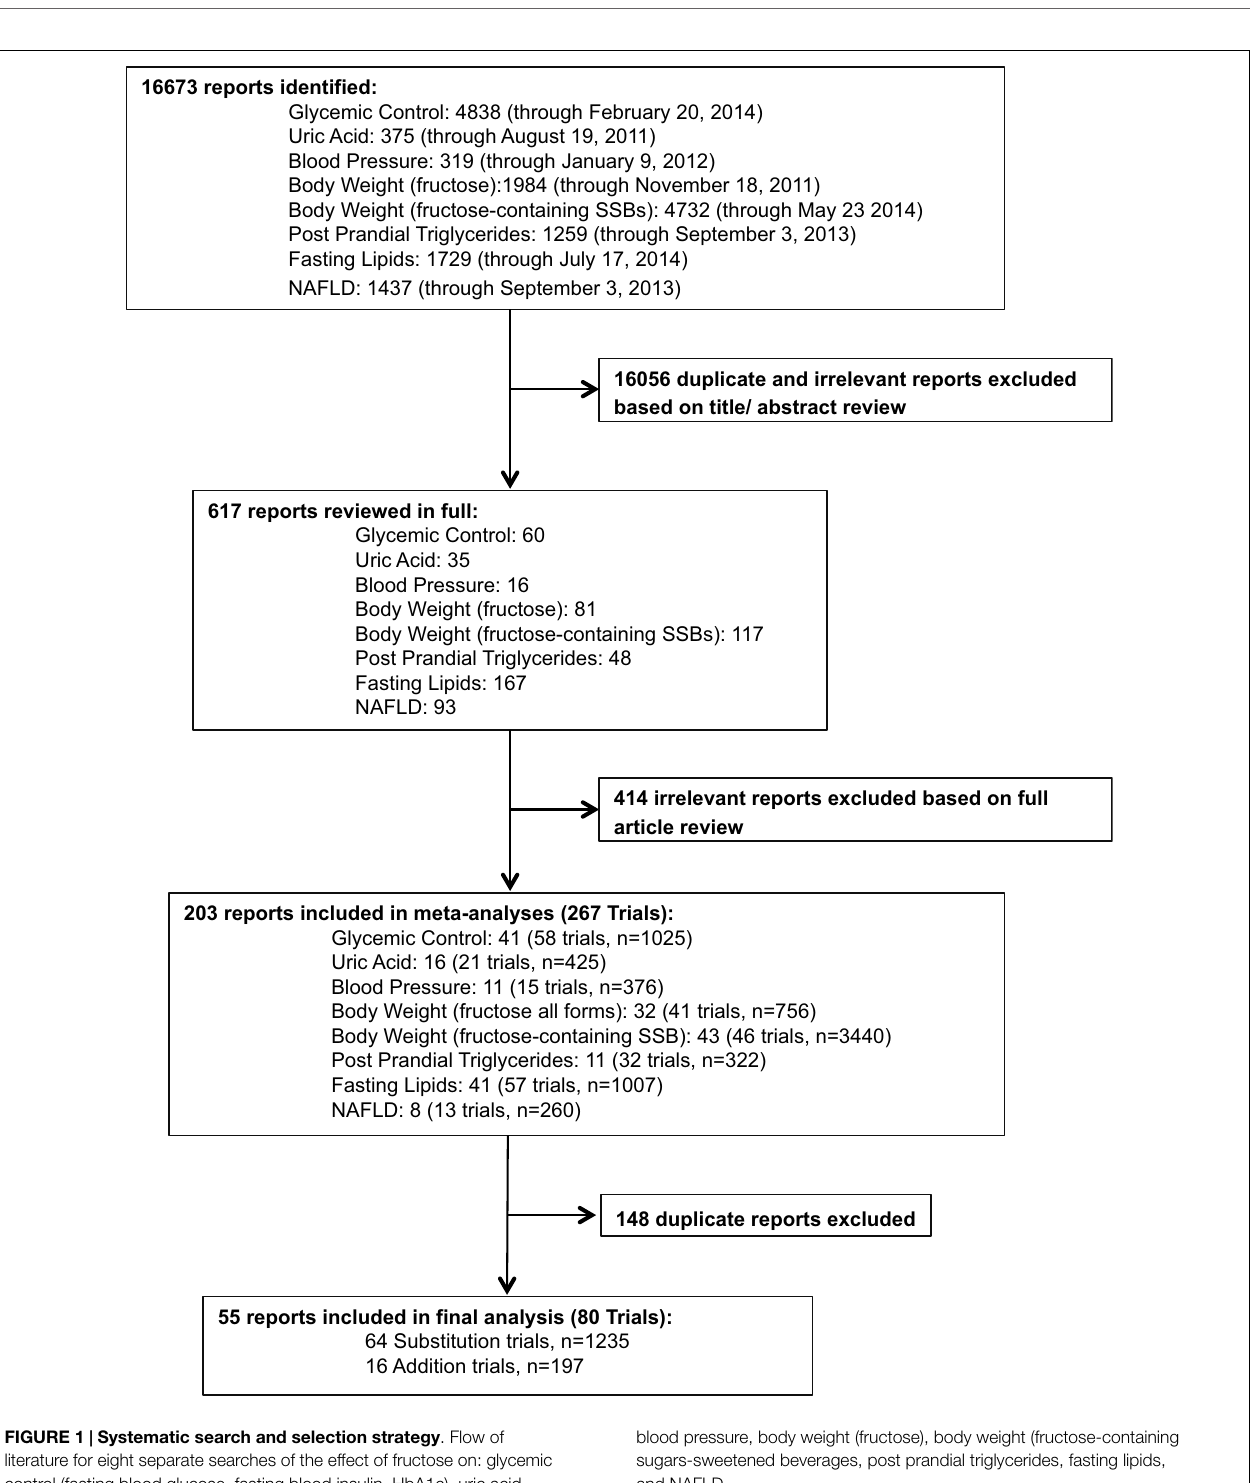
FIGURE 1 | Systematic search and selection strategy . Flow of literature for eight separate searches of the effect of fructose on: glycemic control (fasting blood glucose, fasting blood insulin, HbA1c), uric acid,